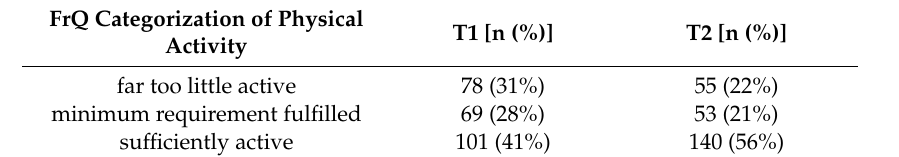
Table 2. FrQ Categorization of Physical Activity. Results display categorization of PA su ffi ciency in FrQ. Time points are T1: before COVID-19 pandemic; T2: during lockdown. (Wilcoxon p -value: p < 0.001).